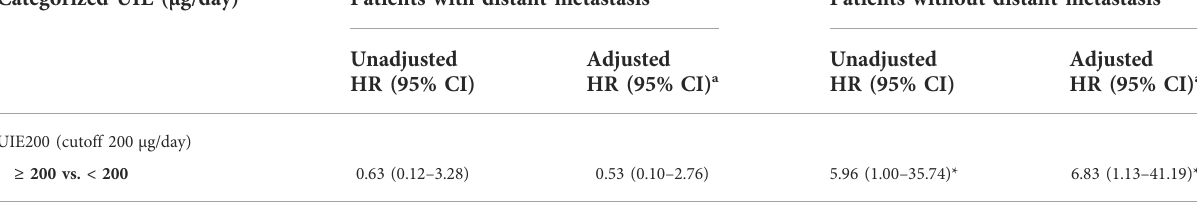
TABLE 5 Relative hazard ratios (HRs) and 95% con fi dence interval(CI) of progression for urinary iodine excretion (UIE) strati fi ed by distant metastasis using the Cox proportional regression analysis. Categorized UIE